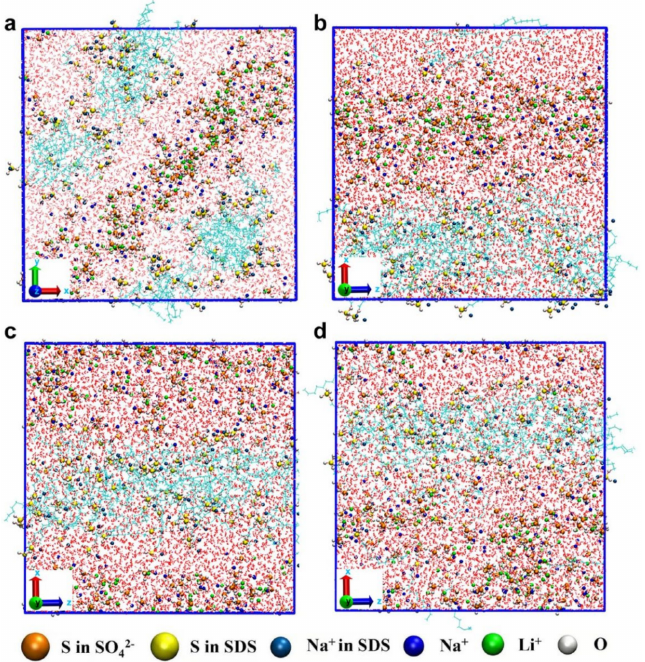
Figure 3. Molecular dynamic simulation results for low-temperature LN-SDS-90 applying a voltage of 2 V nm − 1 at ( a ) 258.15 K, ( b ) 263.15 K, ( c ) 268.15 K, and ( d ) 273.15